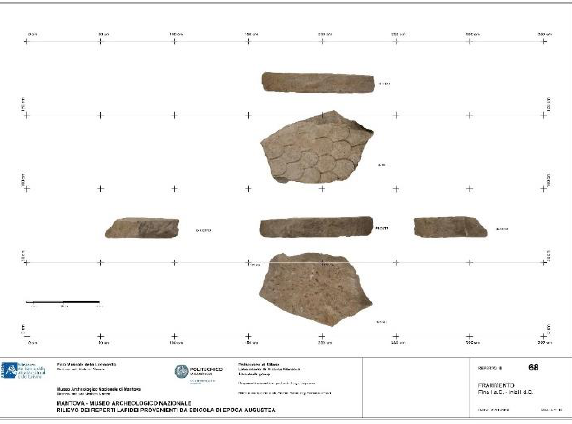
Figure 2: documentation of a single element of the roof. The 6 orthophotos allow to have metric information and to understand the shape and the characteristics of the